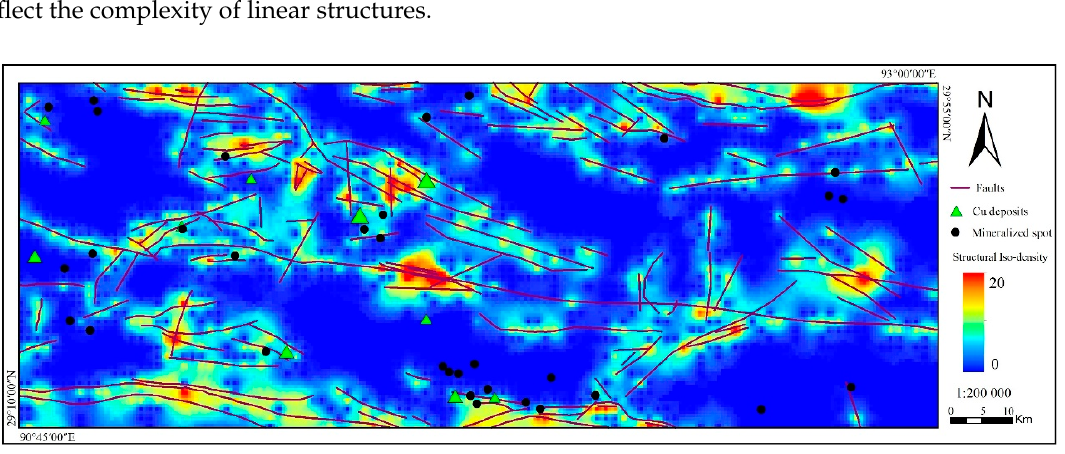
Figure 5. The structural buffer map.